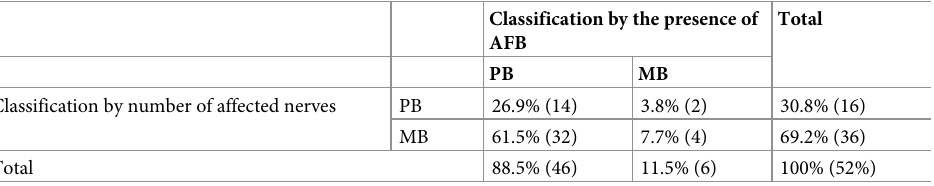
Table 3. Operational classification of pure neural leprosy based on the number of affected nerves and the presence of acid-fast bacilli (AFB) in the nerve